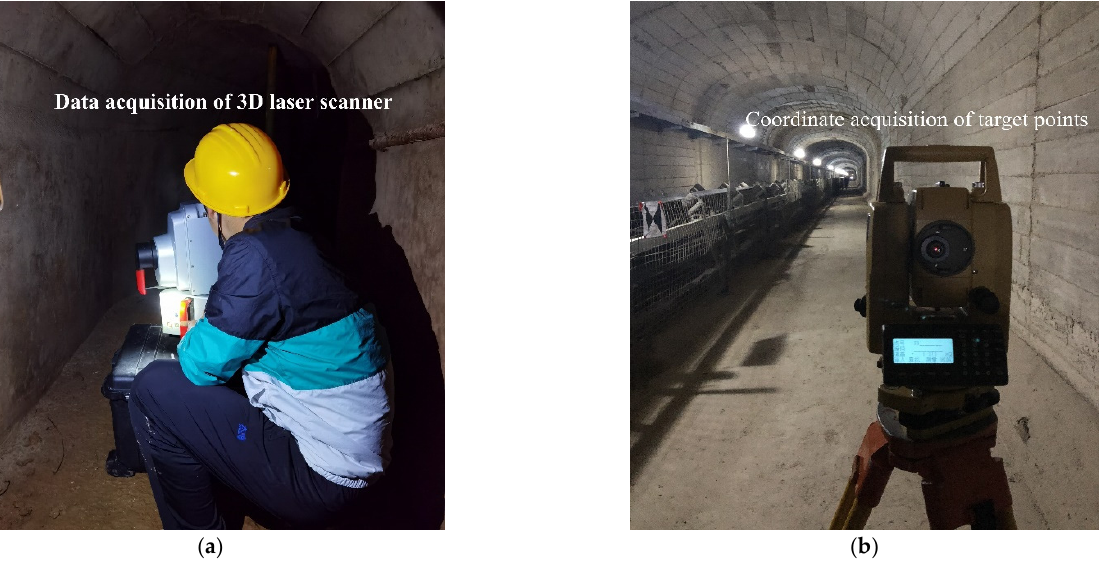
Figure 5. Point cloud data acquisition diagram of manhole roadway. ( a ) Point cloud data acquisition of 3D laser scanner; ( b ) Coordinate data acquisition of target